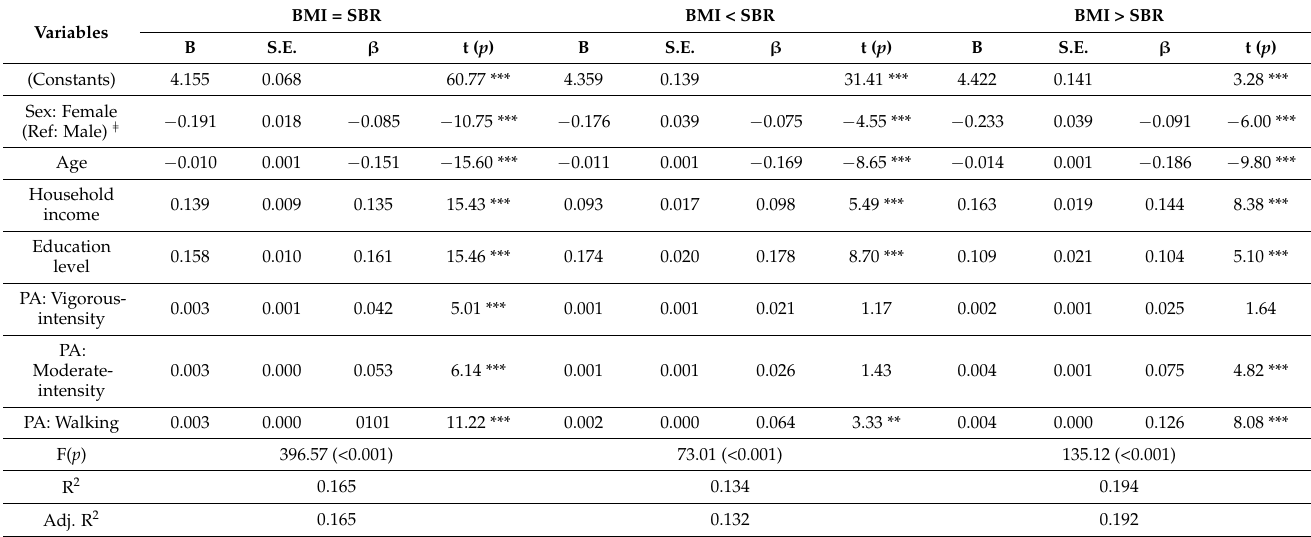
Table 6. Factors affecting health-related quality of life according to BMI and subjective body reception with multiple regression